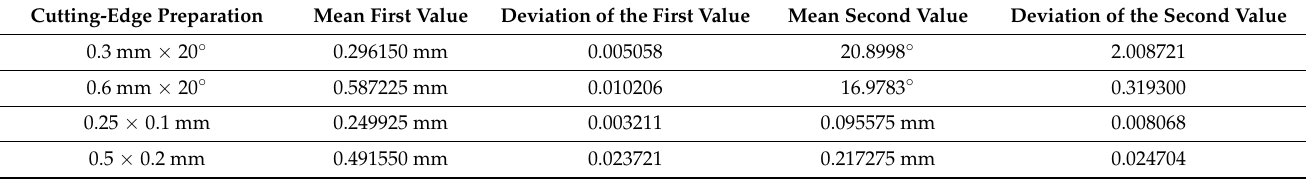
Table 4. The mean values of the obtained chamfers and fillets and their standard deviations.